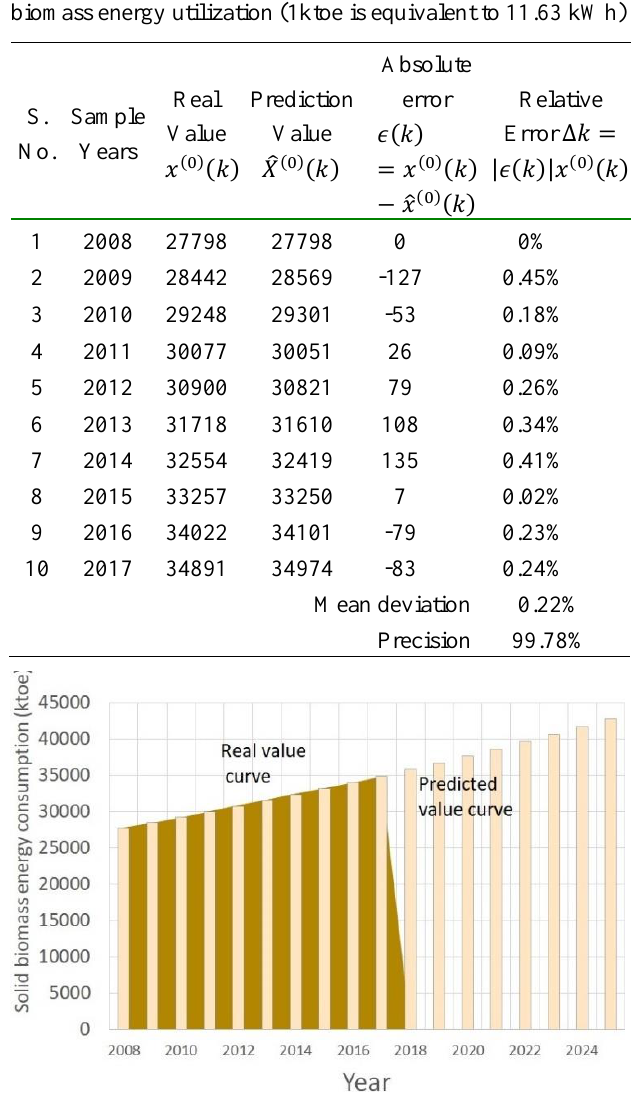
Predicted energy in (ktoe) & deviations of Ethiopian solid